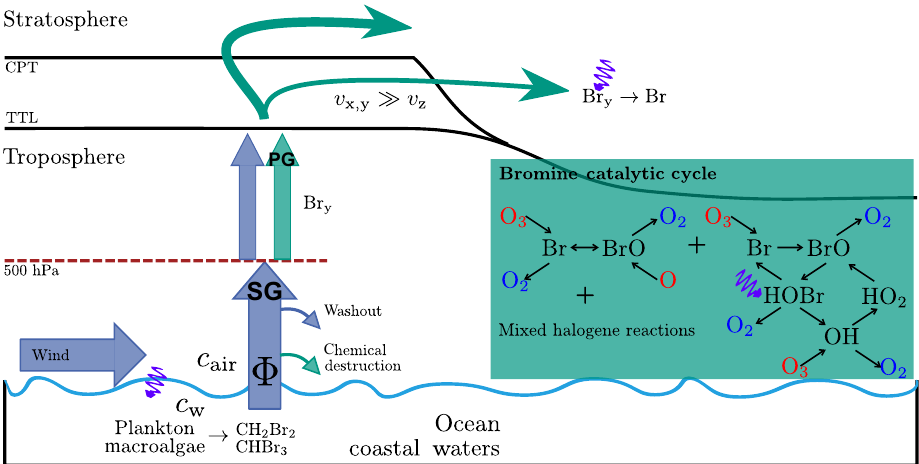
Figure 1. Scheme of VSLS emission and catalytic cycle of ozone depletion involving bromine. (left) VSLS are produced by plankton and macroalgae predominantly in coastal waters. They are emitted through gas exchange between ocean and atmosphere. These organic source gases (SG) undergo chemical transformation into inorganic product gases (PG). Both are convectively transported through the tropical tropopause layer (TTL). Through photochemical decomposition, reactive bromine Br y is provided to the stratosphere. (right) Two examples of catalytic cycles of ozone depletion involving bromine. A + indicates increasing order of catalytic complexity. Reactants are shown in red, catalysts in black, and products in blue. Photochemical reactions are indicated by a violet